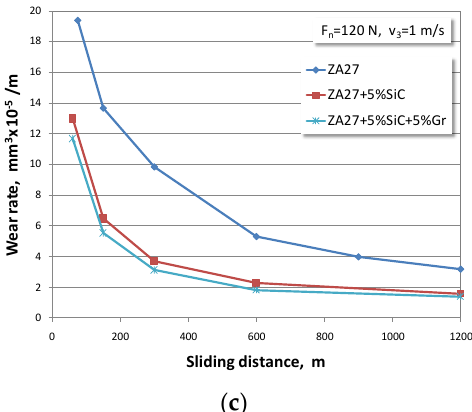
Figure 5. Wear rates for normal load of 120 N and sliding speeds of: ( a ) v = 0.25m/s; ( b ) v = 0.5m/s; ( c ) v = 1 m/s.